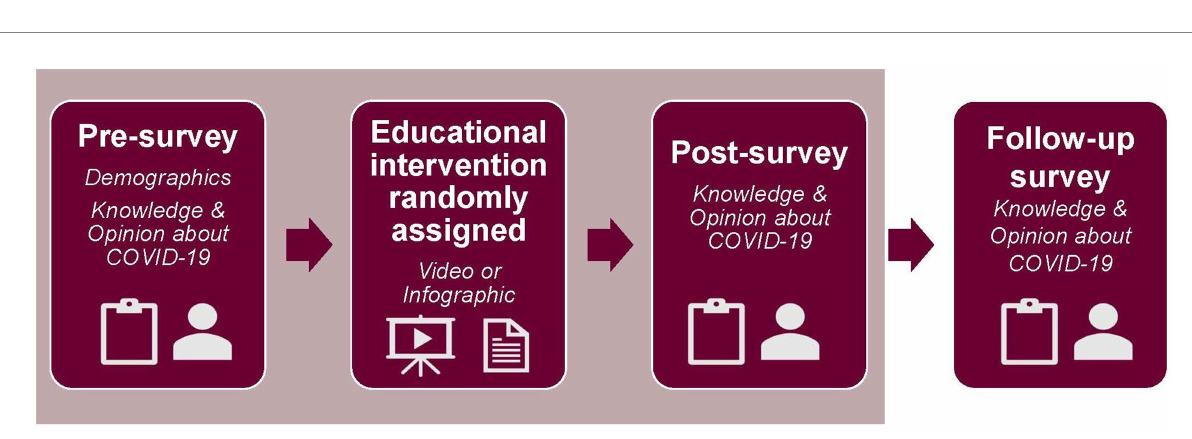
FIGURE 2 Survey flow. Three parts of the survey, illustrated under the tan-colored rectangle, were completed during one sitting. First, each participant completed the pre-survey, which included demographic and COVID-19 questions. Next, the participants were randomized to receive either a video or infographic educational intervention. Finally, the participant completed the post-survey, which included COVID-19 questions. Three months later, the participants received a follow-up survey, which included COVID-19